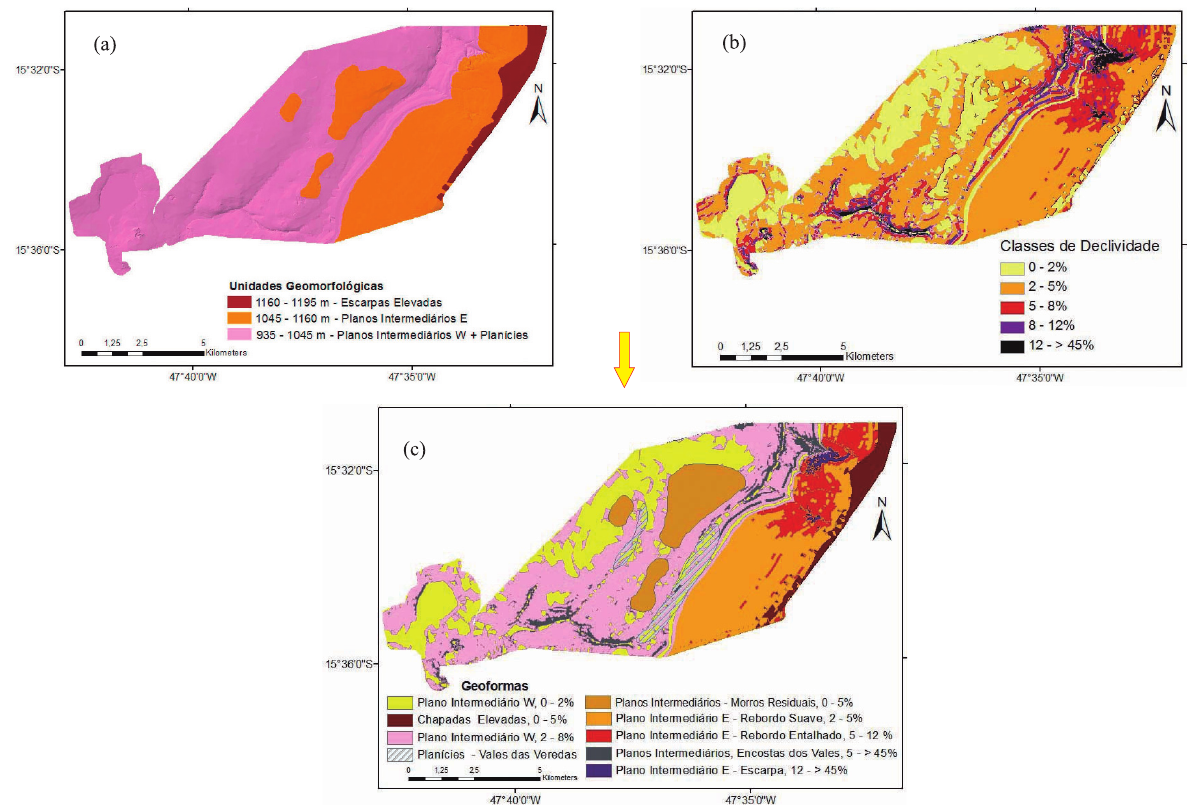
figura 2. mapa de unidades geomorfológicas (a), mapa de classes de declividade, ambos gerados a partir do mdt (modelo numérico do terreno) (b), e mapa de geoformas da estação ecológica de Águas emendadas, df (c), produto do cruzamento-soma dos mapas de unidades geomorfológicas e de classes de